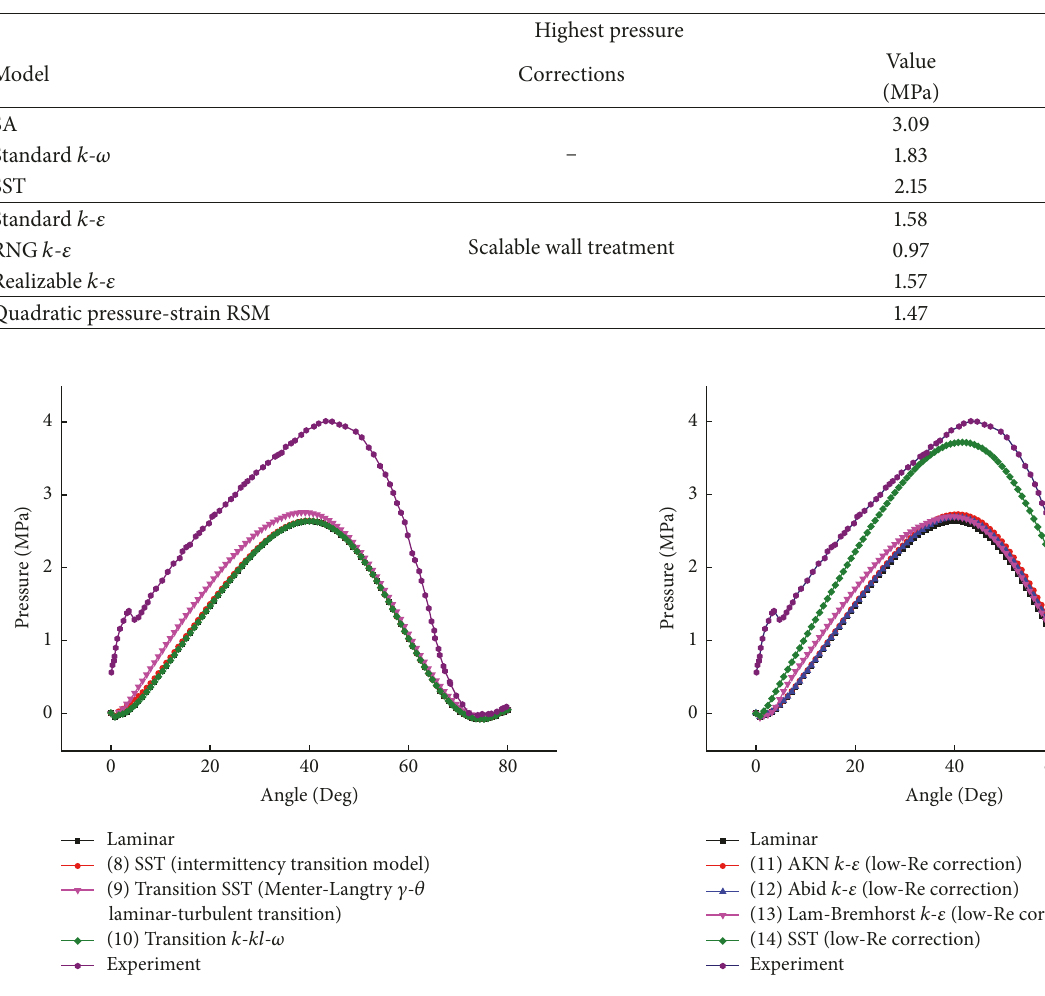
Figure 9: Comparison between the experimental pressure profile at 3000 rpm and under 180 kN and the simulated pressure profiles with the fixed film geometry in pad-side center line for the group of turbulence models with low-Re